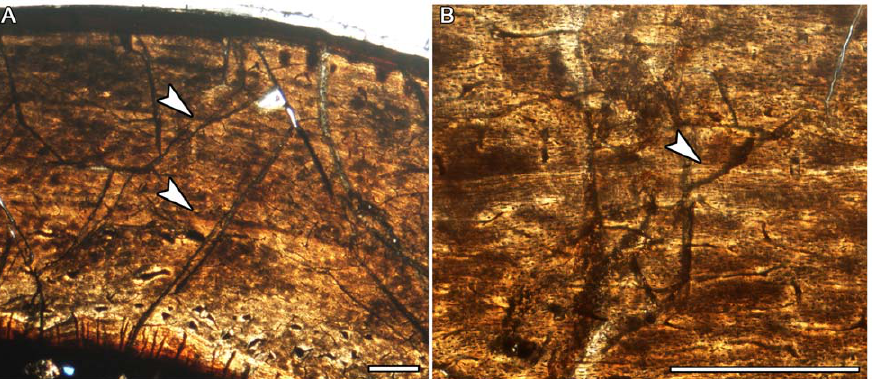
Figure 2. Bone microstructure of polar hypsilophodontid approaching skeletal maturity. Arrows indicate annuli. Scale bars, 500 m m. A) Diaphyseal section of femur NMV 177935 consisting of parallel-fibered tissue with two growth marks within the cortex. B) Detail of inner growth mark showing a distinctive annulus terminating with a bright line.